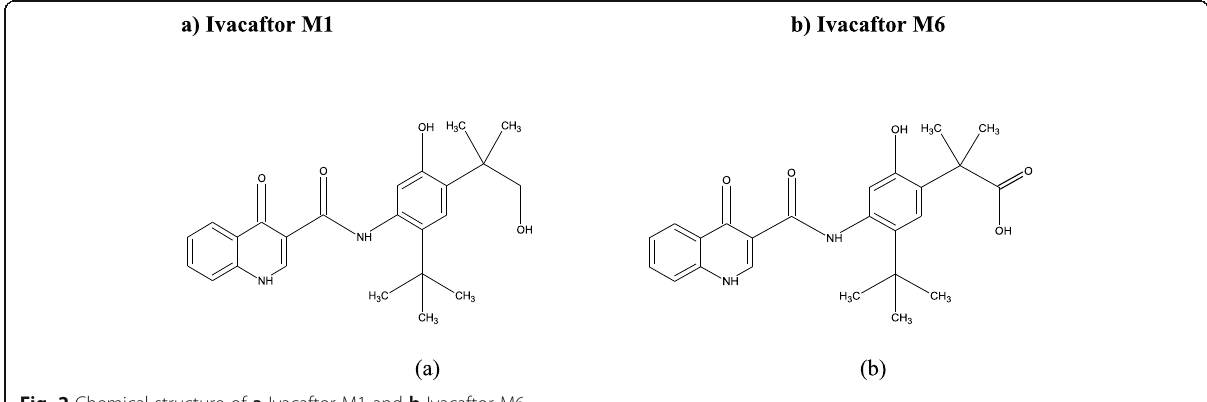
Fig. 2 Chemical structure of a Ivacaftor M1 and b Ivacaftor M6